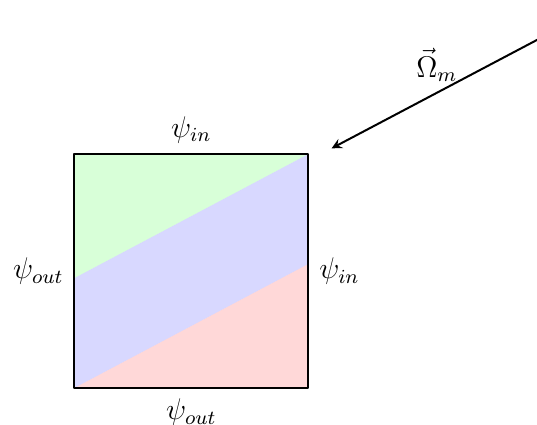
Figure 1: Example slicing of a square into three slices where each slice has a unique incoming face, ψ , and outgoing face, ψ in out